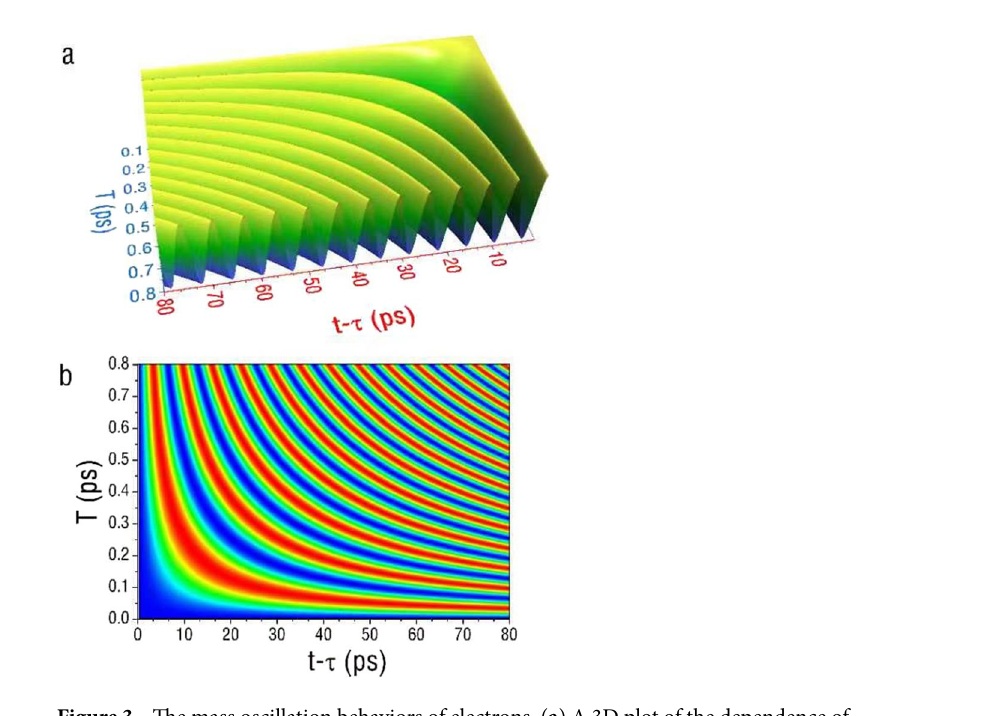
Figure 3. The mass oscillation behaviors of electrons. ( a ) A 3D plot of the dependence of T , t τ . ( b ) A contour plot of the same function. Both � τ , � k 2 cos for the electron case, on T , and t − − figures illustrate the intensity oscillations from two interfering electron beams, reflecting the mass oscillations (cid:31) (cid:30)(cid:30) (cid:31) induced by the uncertainty in the electron’s initial wave vector (cid:31) k . In this simulation, we consider neutrino from reactors with relativistic mass-energy of 0.55 MeV, v 0 = 1.1 × 10 8 m/s, (cid:31) k of 10 10 m −1 and τ of 0.91 µs for traveling τ 1 km to a detector. The oscillation period appears to be on the order of ps along the time axis of t −